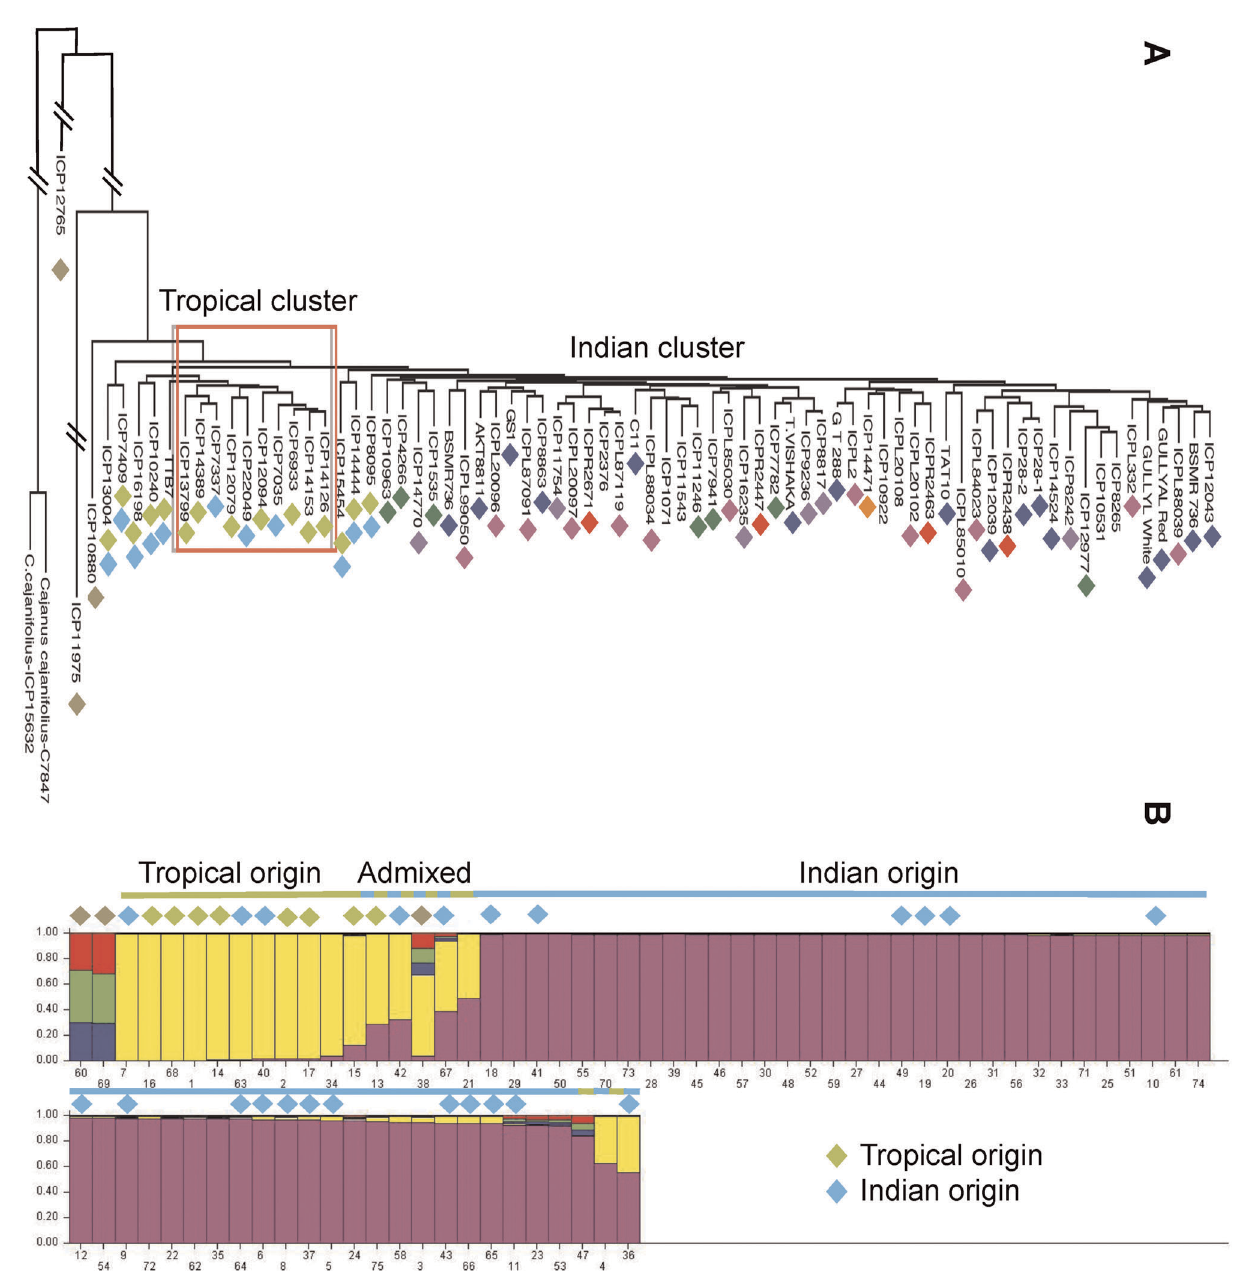
Figure 5. Population structure of cultivated Cajanuscajan . Panel A , Weighted Neighbor-Joining tree depicting pairwise relationships between accessions. Colors denote the nature of individual accessions: Blue diamonds, cultivars and elite varieties; Pink diamonds, landraces; purple diamonds, ICRISAT reference material; Green diamonds, Core collection; Red diamonds, R-line; Orange diamonds, Minicore; Light green diamonds, Tropical; light blue, Indian; Light brown diamonds, Philipines. Genotypes with admixture between Indian and Tropical subgroups are designated by both light green and light blue diamonds. Panel B , population subdivisions with cultivated genotypes revealed by STRUCTURE. Green diamonds, genotypes with tropical distribution; blue diamonds, genotypes with an Indian sub-tropical distribution. Admixed genotypes are those with fractional membership in multiple groups. Likelihood values for each value of K are given in Table S4.